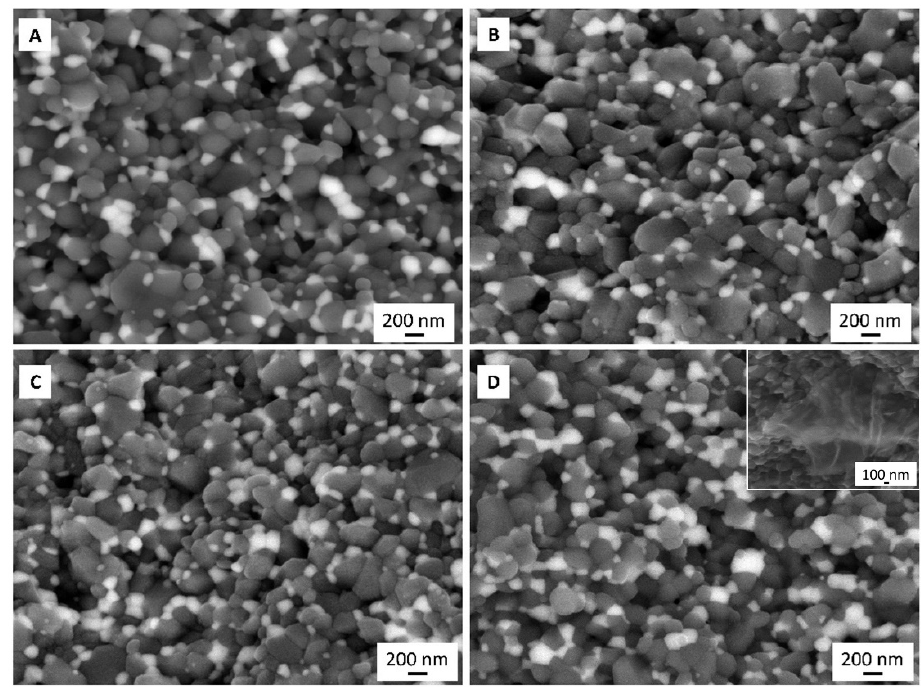
Figure 6. SEM images of fracture surfaces for 0-G ( A ), 0.5-G ( B ), 1-G ( C ), and 5-G ( D ) sintered composites. Close-up of fracture surface with the presence of rGO in microstructure ( D ). These images confirm the uniform distribution of ZrO 2 in the ceramic matrix. Only in the 5-G composition were agglomerates of ZrO 2 observed. The micrograph shows that the ZrO 2 grains are embedded around the Al 2 O 3 grain.